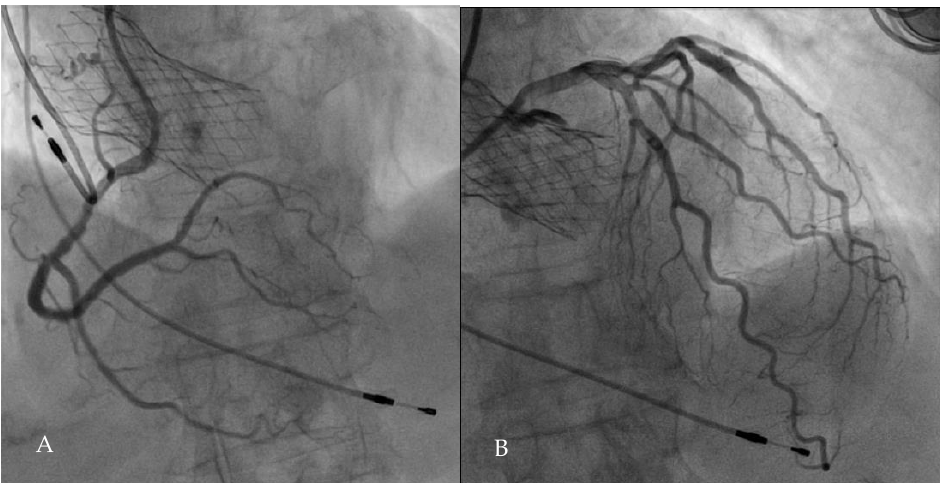
Figure 4. Feasibility of coronary access post TAVI. Coronary angiography performed after TAVI thorough the CoreValve Evolut R struts. ( A ) Right coronary artery selective cannulation using a Judkins right catheter (JR 4, Cordis Corporation, Bridgewater, NJ, USA); ( B ) Left coronary artery selective cannulation with an extra backup support catheter (EBU 3.5, Medtronic Inc., Minneapolis, MN, USA).